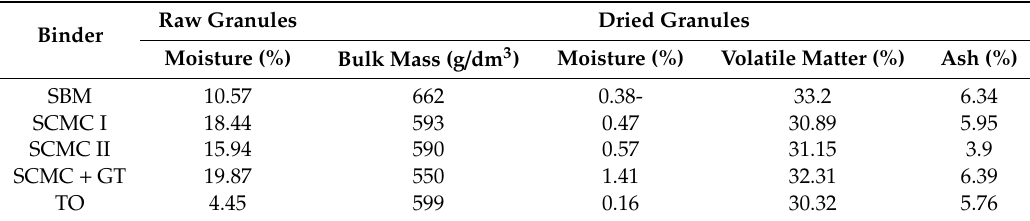
Table 6. Average properties of raw and dried granule samples.